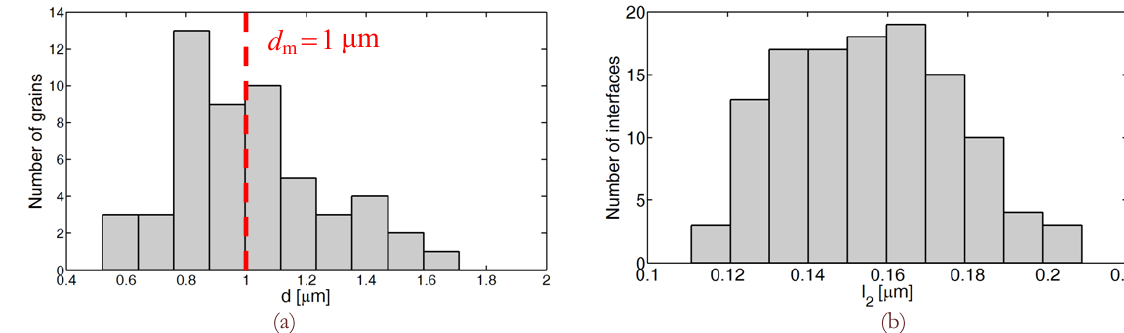
Figure 6: (a) Grain size distribution and (b) interface thickness distribution of the microstructure shown in Fig. 5.